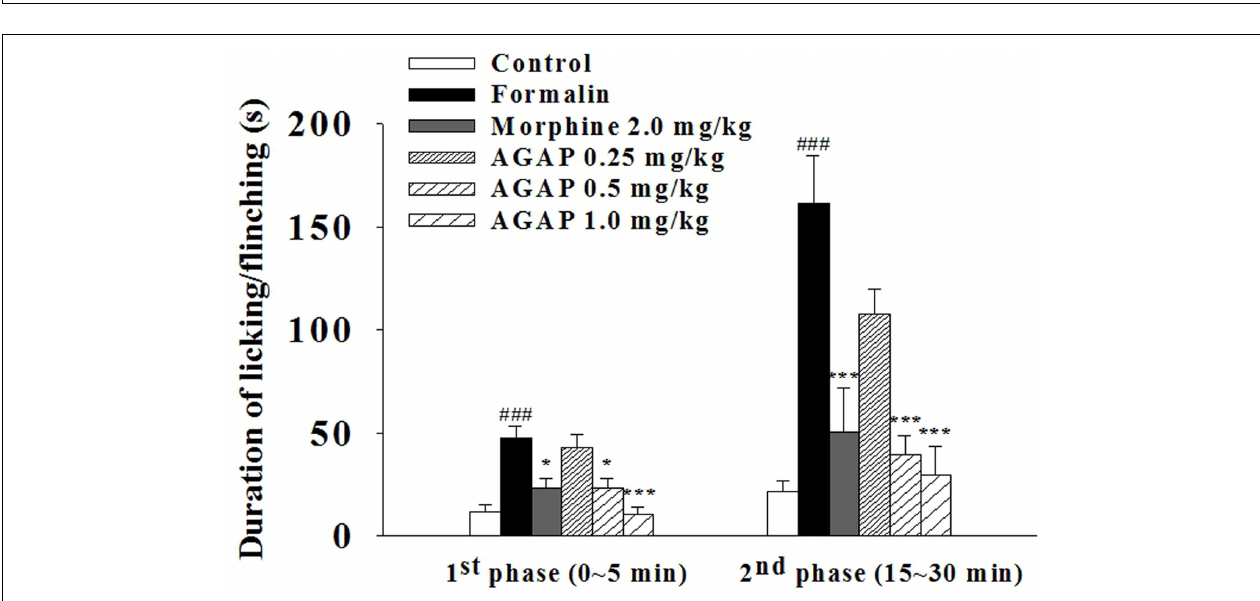
FIGURE 2 | Reaction time of animals in hot plate test: 0, 30, 60, 90, and 120 min after treatment of AGAP and morphine. Animals were pretreated with vehicle, morphine (5 mg/kg), AGAP (0.25, 0.5, and 1.0 mg/kg) prior to the tests at 55 ◦ C. Each column represents the mean with X ± SEM. for twelve mice in each group. The symbols denote the significance levels: ∗∗ p < 0.01, ∗∗∗ p < 0.001 compared with control group. Morphine and 1.0 mg/kg AGAP were not statistical difference ( p > 0.05). Data are shown as the mean ± SEM ( n = 12 per group). P values are from two-way ANOVA followed by Bonferroni test.